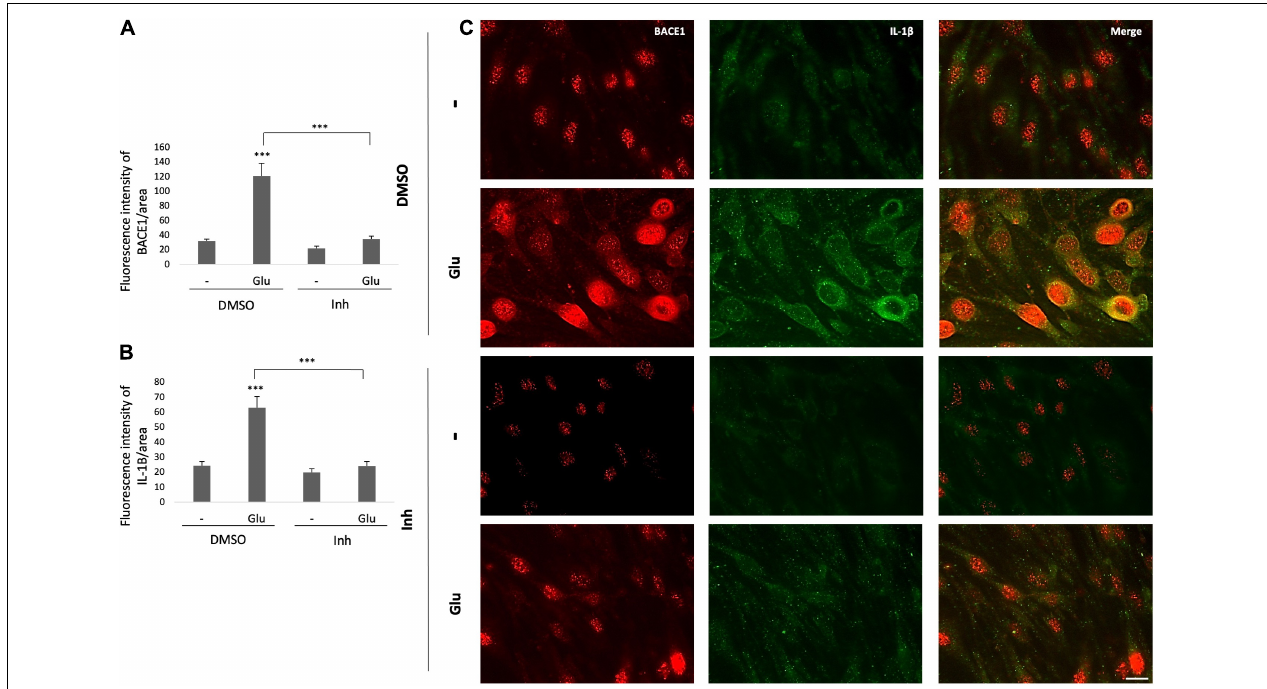
FIGURE 5 | BACE1 inhibitor reduces the glutamate-induced increases in BACE1 IR and the IL-1 β inflammation marker in ECs. (A,B) Fluorescence intensities of BACE1 and IL-1 β , respectively, per unit area, quantified from 20 cells per treatment for each n ( n = 4 performed in duplicate) and divided by unit area. (C) Representative images showing BACE1 (red, visualized with Alexa Fluor 594) and IL-1 β (green, visualized with Alexa Fluor 488) expression in ECs (bEnd.3) under different treatments. Magnification: 60x. Scale bar: 20 µ m. The data are presented as the means ± SEM, ANOVA followed by Tukey’s test. *** P < 0.001. The bEnd.3 cell cultures were pretreated on DIV 8 with β -secretase inhibitor IV (CAS 797035-11-1, Merck) at 1 µ M. Twenty-four hours later, the cells were treated with glutamate at 125 µ M for 20 min and were subsequently treated with the inhibitor again. On DIV 10 the cells were fixed for immunofluorescence